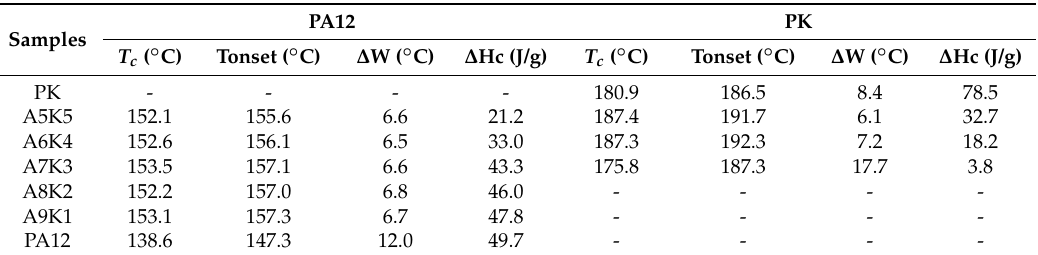
Table 2. Crystallization parameters of PA12, PK and the blends determined from Figure 6a.